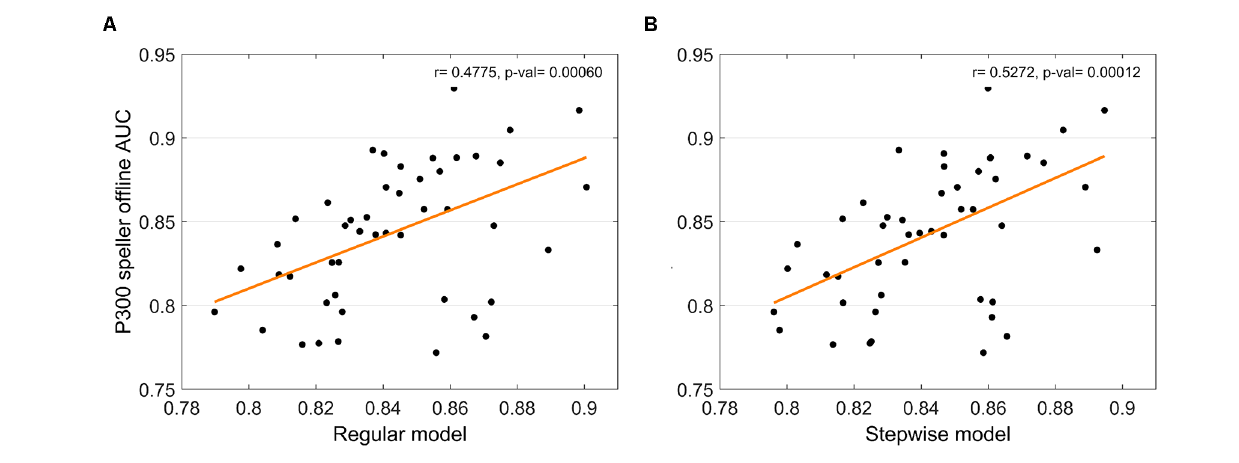
Frontiers in Human Neuroscience |